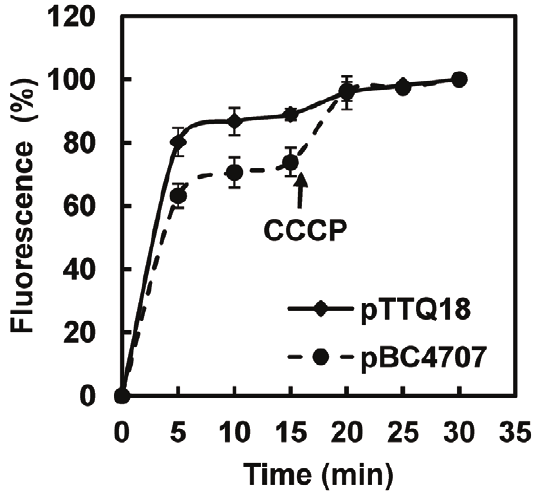
Figure 7. Accumulation of Norfloxacin in E.coli DH5 a D acrAB (pBC4707) and DH5 a D acrAB (pTTQ18). The fluorescence of intracellularly accumulated norfloxacin was measured at 280 nm excitation and 445 nm emission in the supernatant of bacterial extracts. Bacteria expressing BC4707-RGSHis 6 are indicated by circles whereas bacteria carrying the empty vector are shown as diamonds. The assay was started by the addition of 100 m M norfloxacin at time 0 min. At 15 min, the protonophore CCCP (100 m M) was added to disrupt the proton motive force. Shown are averages and standard deviations from two independent experiments.